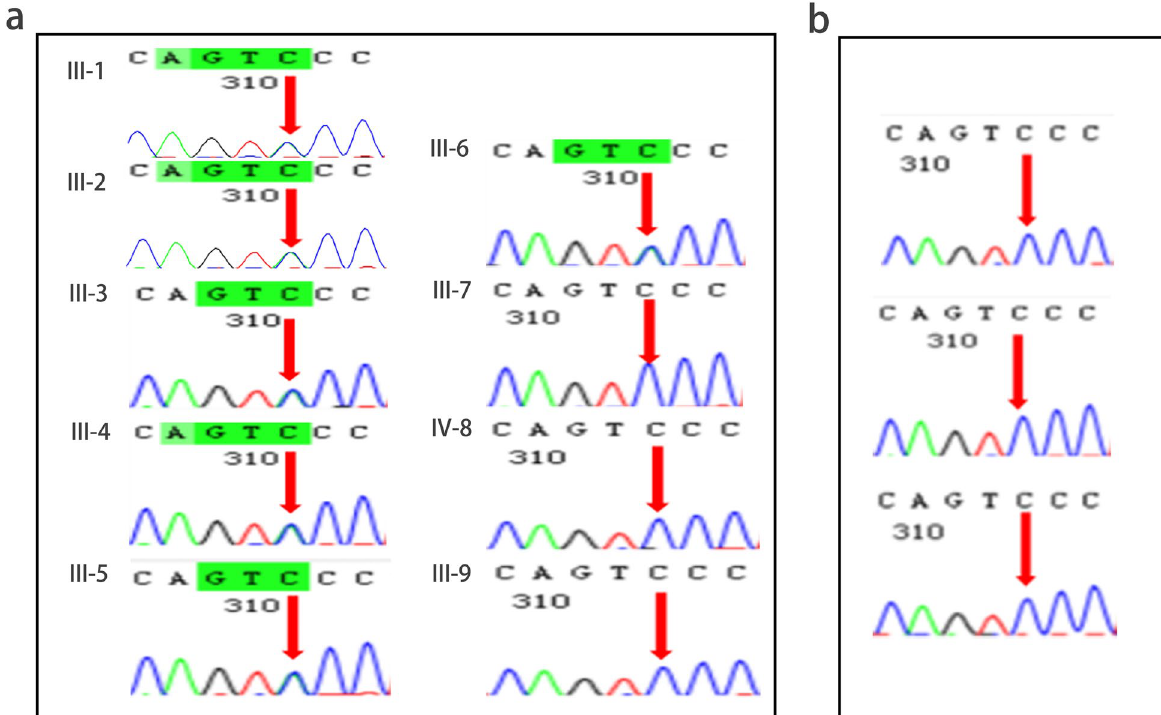
Fig. 2 Sanger sequence MARS1 in Family 1 and nonfamilial TN subject group. a We performed Sanger sequencing to confirm the MARS1 mutation and found that its presence was widespread in Family 1. Roman numerals denote generations. Numbers 1–3 are probands in Family 1. Numbers 3–9 are subjects in the FTN family member group in Family 1. The MARS1 mutation is identified in numbers 3–6. Numbers 6–9 are negative. b We performed Sanger sequencing to confirm the MARS1 mutation (c.2398C > A) in nonfamilial TN subject group. Three subjects did not have MARS1 mutation. All the probands and subjects in Fig. 2 were subjected to